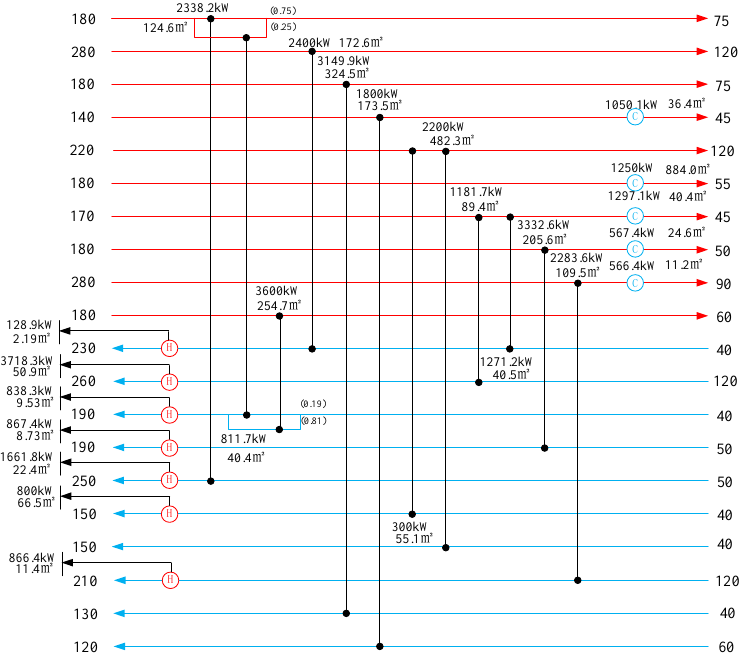
Figure 7. Solution of case 4 obtained by NNM model with serial structures; the TAC is 1,724,768 $ / a. Table 8. Comparison results of case 4.